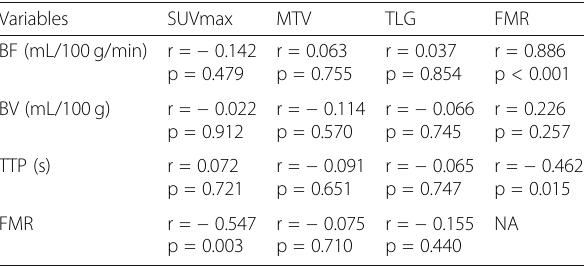
Table 2 Correlations between perfusion and